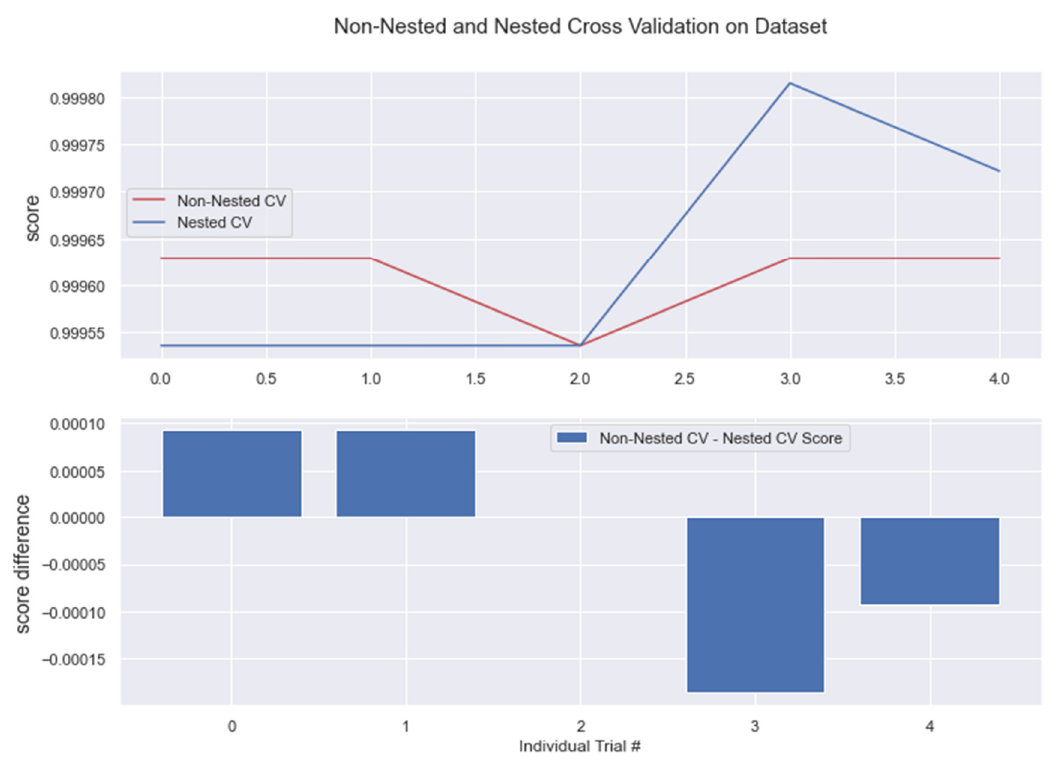
Figure 19. Non-Nested and Nested cross-validation on RC algorithm.